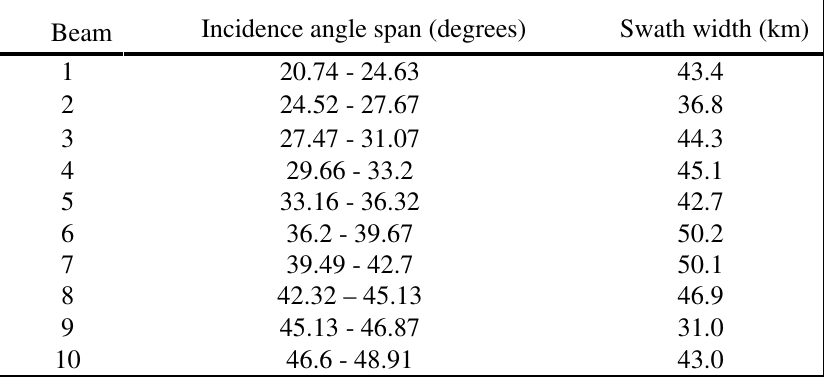
Table 2. MAPSAR beams and incidence angles for the Medium Resolution Mode.